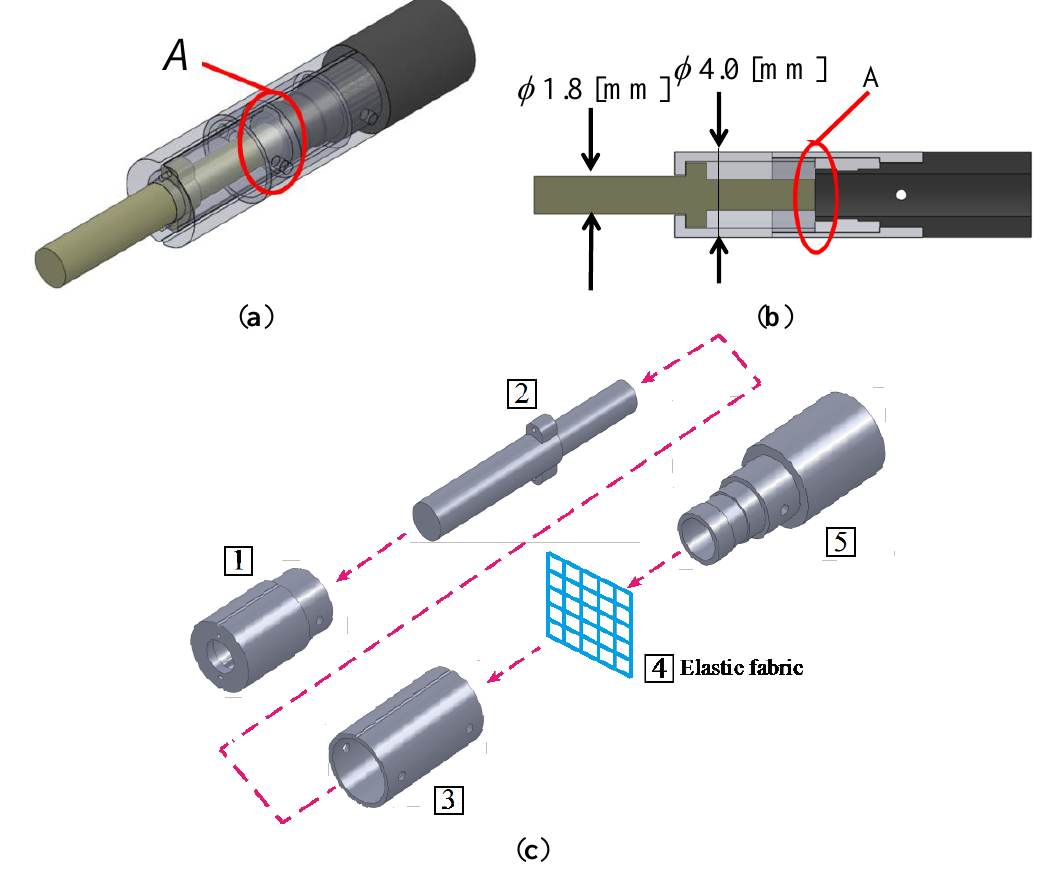
Figure 3. ( a ) Design of force visualization part: three-dimensional view ( b ) Design of force visualization part: sectional view ( c ) Overview of assembly